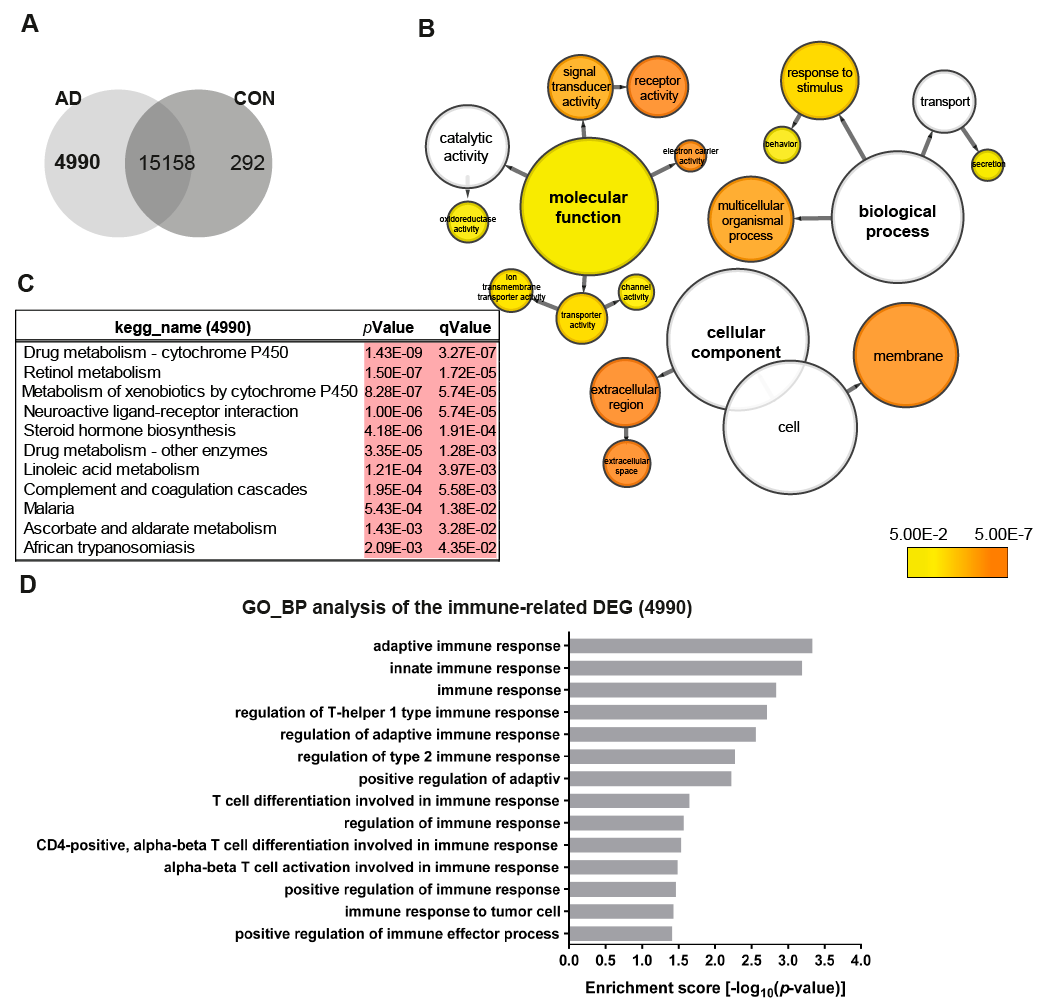
Figure 2. Distinct gene expression profiles associated with AD neuronal networks. ( A ) Venn diagram illustrating genes exclusively expressed in the AD neural network (4990), the control (CON) network (292) or common between both (intersection -15158) (detection p -value < 0.05). ( B ) BiNGO analysis of the di ff erentially expressed genes (DEGs; 4990) exclusively expressed in the TREM2 neuronal network (4990). The orange color of the circles correspond to the level of significance of the over-represented gene ontology (GO) category and the size of the circles is proportional to the number of genes in the category ( p -value < 0.05). ( C ) Kyoto Encyclopedia of Genes and Genomes (KEGG) pathway analysis of the genes exclusively expressed in the AD neuronal network (4990). ( D ) Significantly enriched gene ontology (GO) terms (biological processes) of the genes exclusively expressed in the AD neuronal network (4990) associated with immune system processes ( p -value < 0.05).